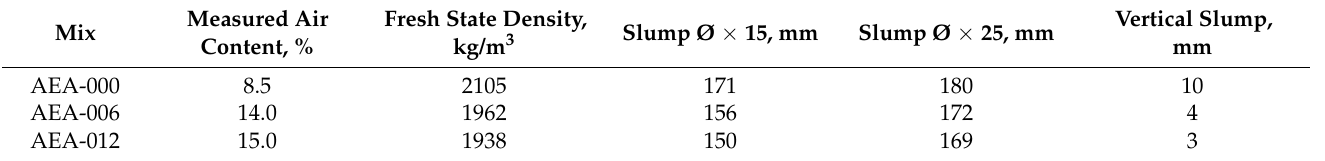
Table 2. Fresh state properties of mixes AEA-00, AEA-006, and